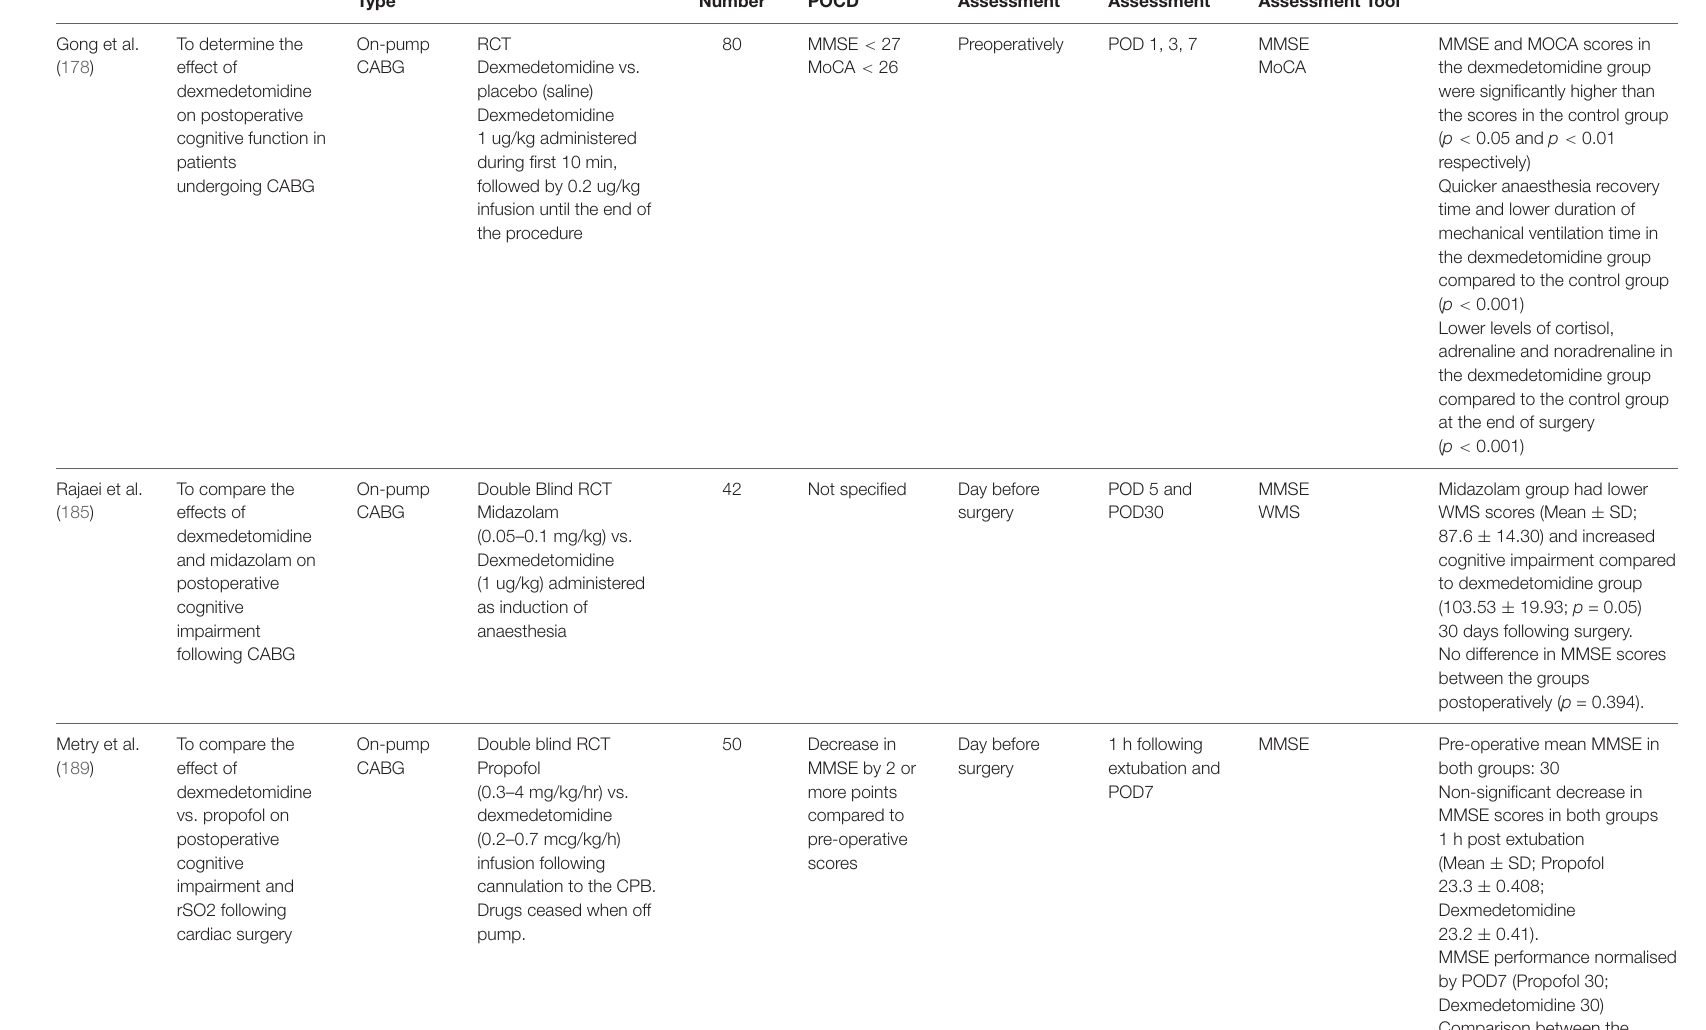
TABLE 8 | Studies analysing the effect of dexmedetomidine on postoperative cognitive functioning following cardiac surgery.